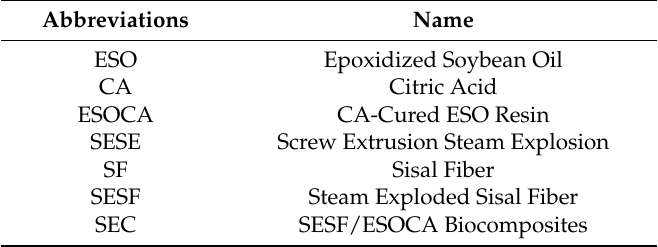
Table 1. The abbreviated names of different samples.